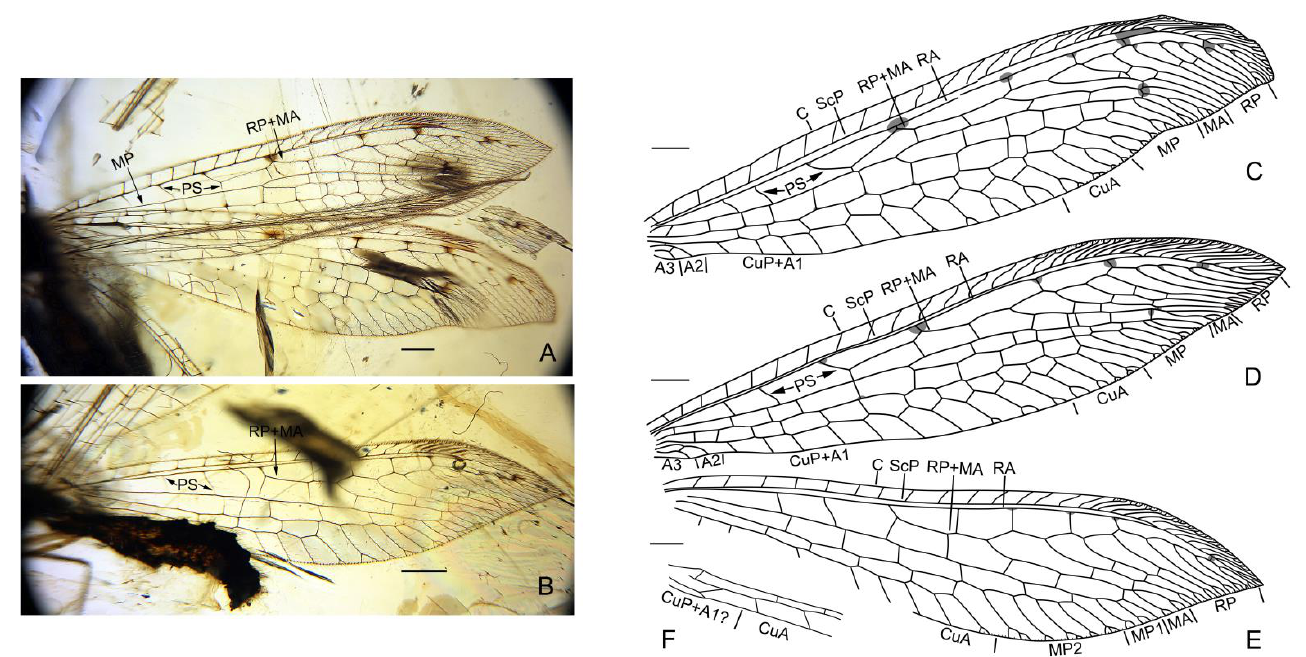
Figure 3. Paradoxoleon chenruii gen. et sp. nov., holotype: STJ-703. ( A , B ) Photographs of wings: ( A ) wings; ( B ) right hind wing; ( C – F ) drawings of wings: ( C ) left forewing; ( D ) right forewing; ( E ) right hind wing; ( F ) left hind wing. Scale bar = 1.0 mm.